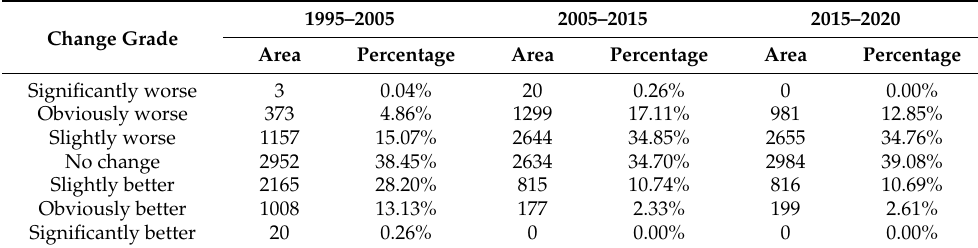
Table 8. Change in the ecological index grade from 1995 to